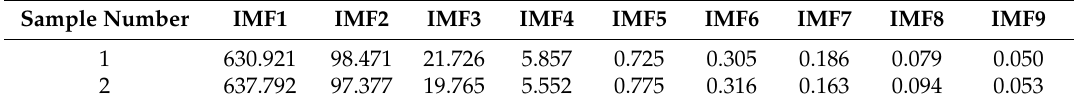
Table 4. intrinsic mode function (IMF) energy for different conditions.